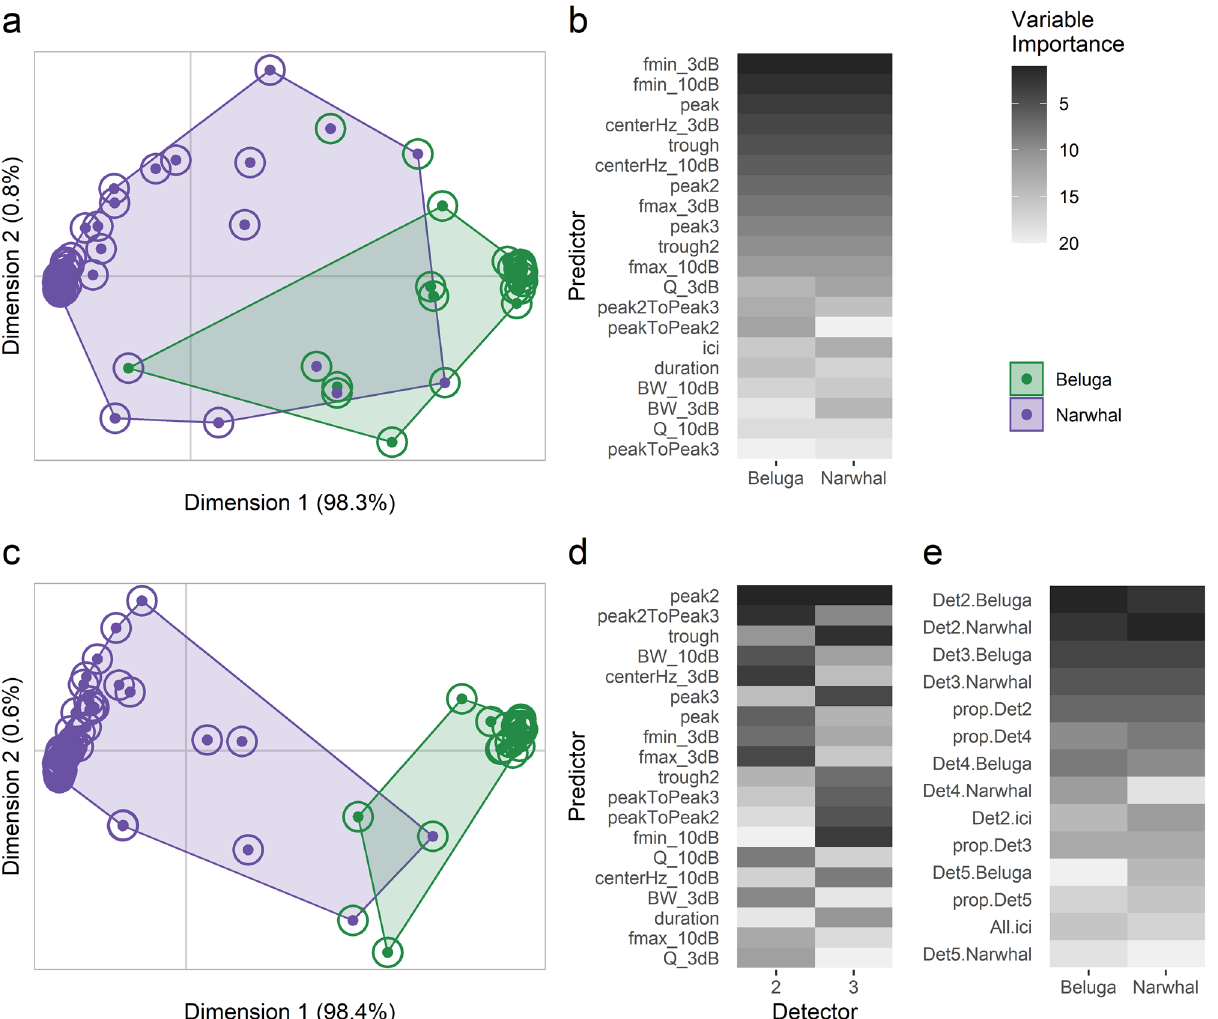
Figure 4. Ordination plots ( a , c ) from a multidimensional scale (MDS) conversion of Random Forest (RF) proximity scores to visualize species classification predictions. The top panel ( a , b ) corresponds to the single RF classification model and the bottom panel ( c – e ) are the results from the BANTER classification model. RF proximity scores are calculated for each pair of objects (i.e., acoustic events) to produce a N × N matrix, where N is the total number of objects. If objects occupy the same terminal node for one tree, their proximity score increases by one. All proximities are normalized by dividing by the total number of trees in the forest. Shaded regions show a-priori species groups with points colored according to their original (inner) and predicted (outer) species. Dimension 1 in ( a ) and ( c ) explains 98.3% and 98.4% of the total variation for the RF and BANTER models, respectively, and dimension 2 explains 0.8% and 0.6% of the variation, respectively. Relative variable importance is shown for both models ( b , d , e ). The heatmaps show ranked variable importance from the least important (light gray) to most important (dark gray). Descriptions of predictors are provided in Table 1 and Supplementary Table